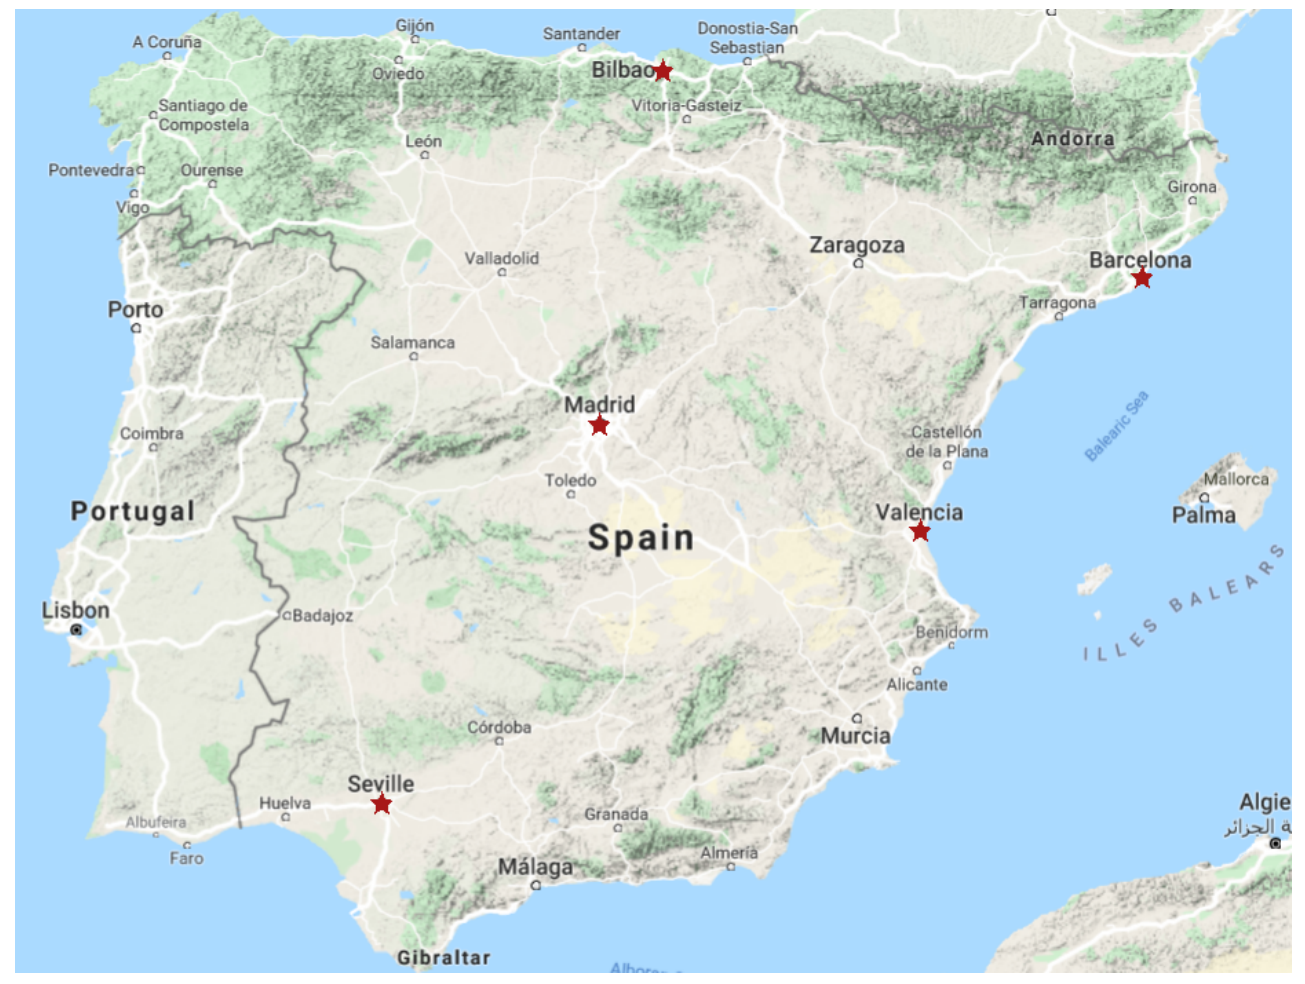
Figure A1. Geographic locations of the